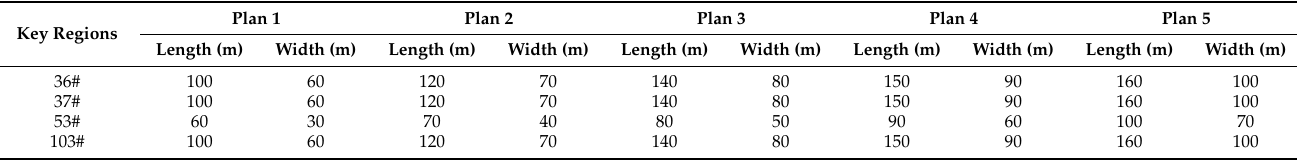
Table 3. The designed scope of the key